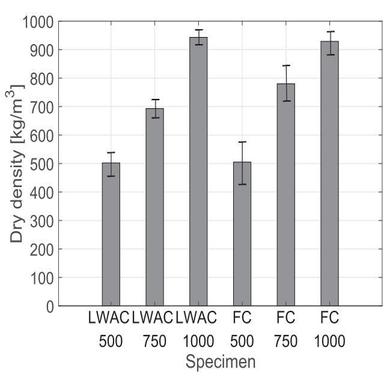
Dry density of LWC specimens.